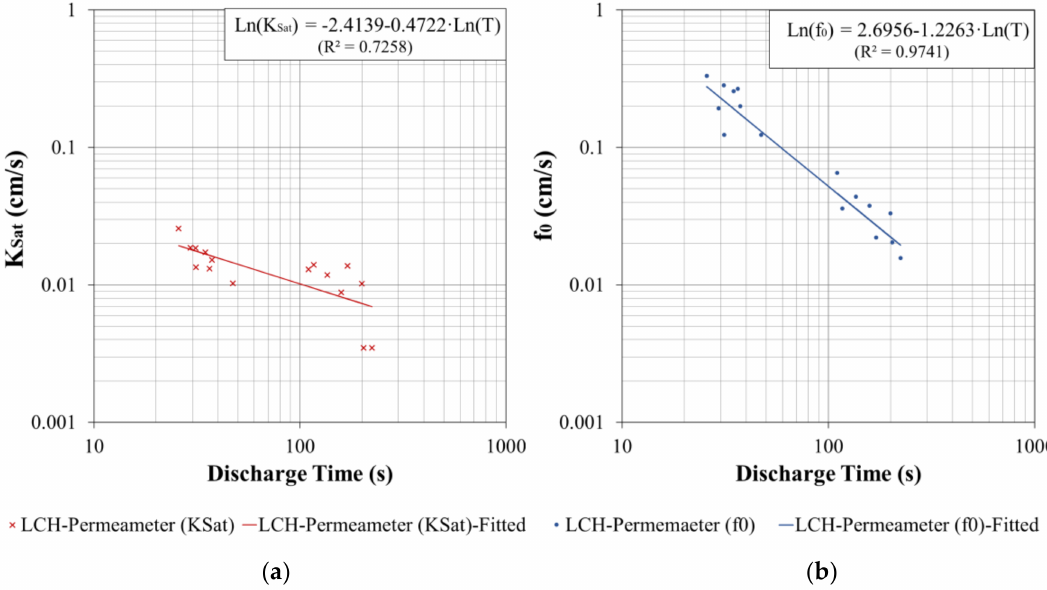
Figure 7. Regression analyses between LCS drainability test results and LCH permeability tests: ( a ) Saturated permeability ( K Sat ); ( b ) Initial infiltration rate ( f 0